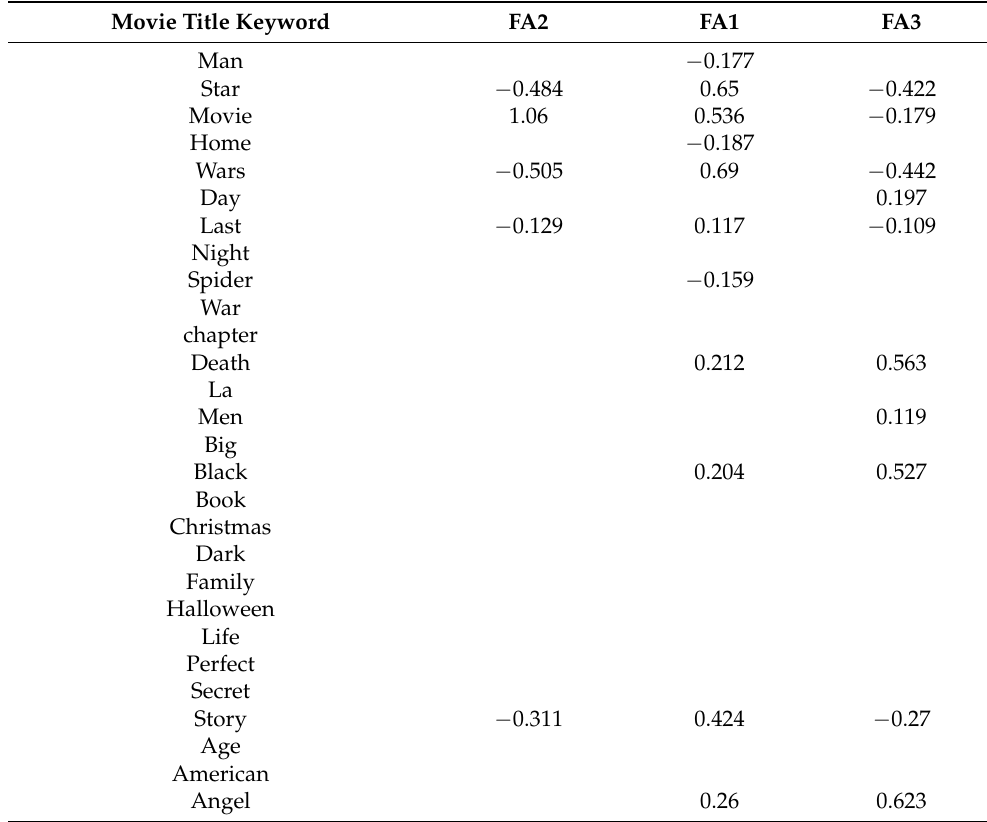
Figure 7. Scree plot indicating the number of retained factors for movies in the United States. Table 3. Three-factor rotated